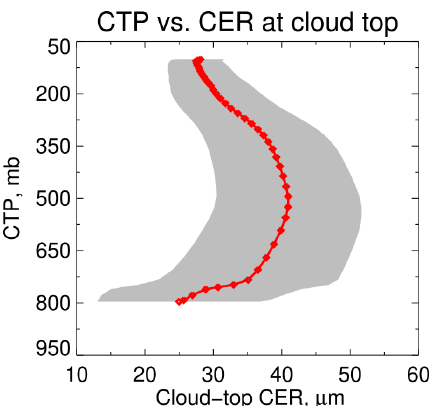
Figure 5. Ice-cloud-top effective radius (CER) vs. cloud-top pres- sure (CTP) relationship used in this study. The red line denotes the mean profile and grey shading 1 standard deviation around the data collected by van Diedenhoven et al.